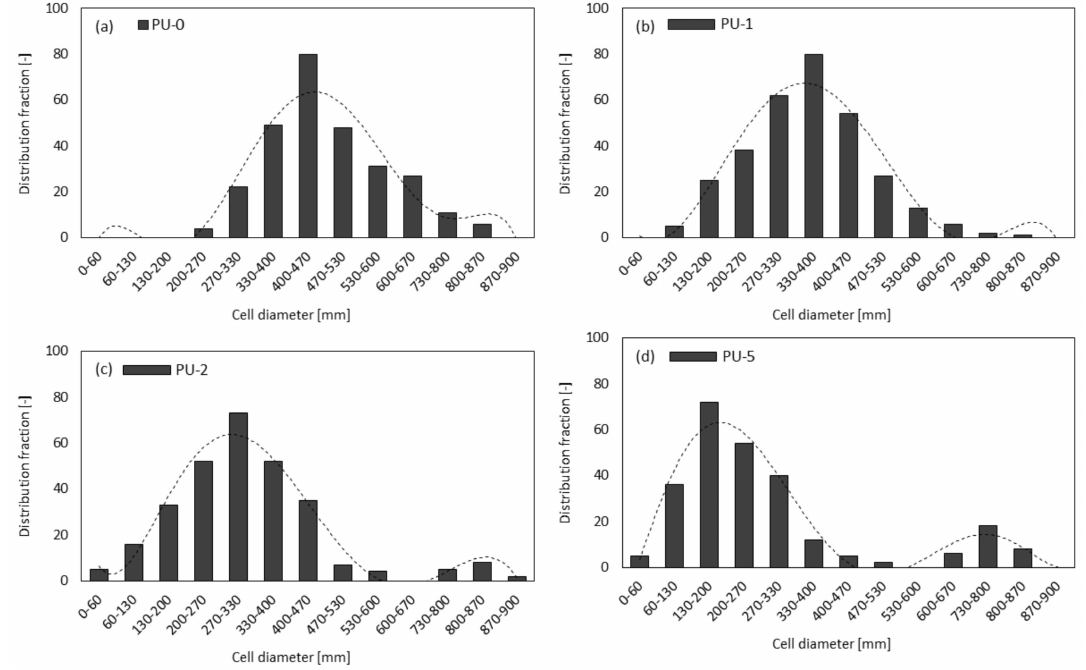
Figure 7. Distribution of cell size of ( a ) PU-0, ( b ) PU-1, ( c ) PU-2, and ( d )